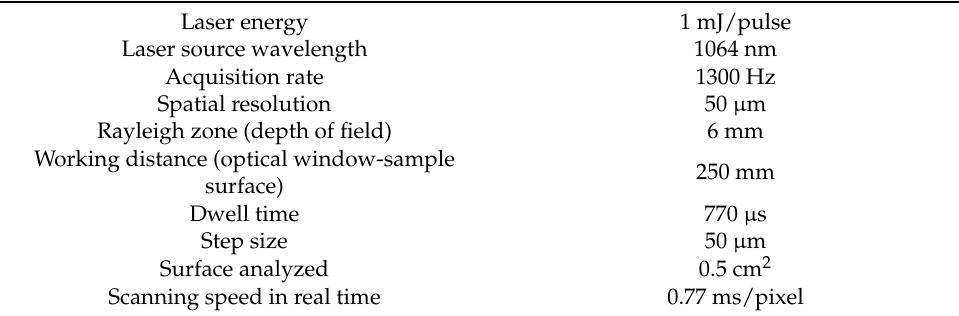
Table 2. CORIOSITY LIBS analysis principal parameters.